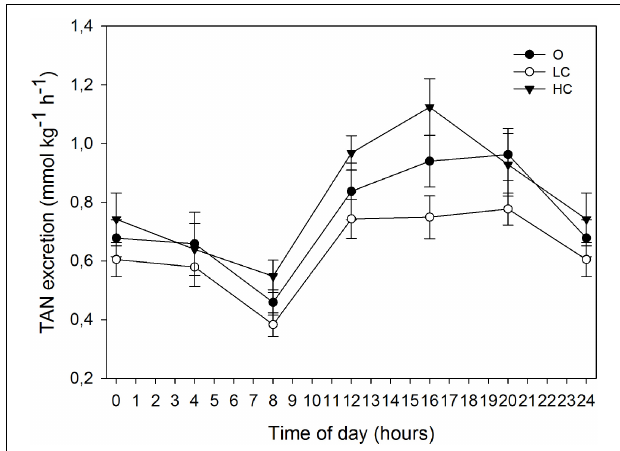
FIGURE 4 | Daily patterns of total ammonia nitrogen (TAN) excretion at different water current velocities. Values are mean ( ± SE) for 3 days of measurements (days 78, 80, and 82 of the growth trial). High current, HC = 1 BL s − 1 ; low current, LC = 0.5 BL s − 1 ; and O = no current ( n = 4).